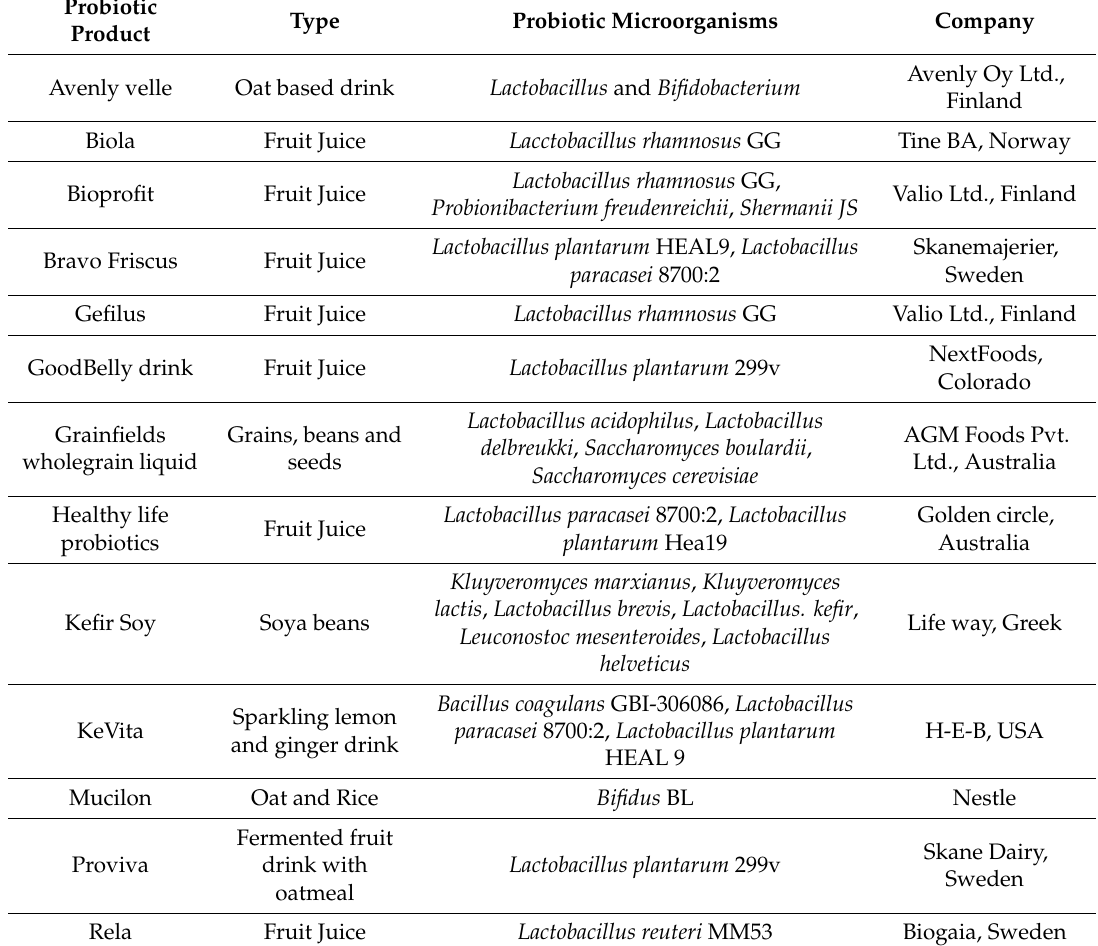
Table 1. Commercially available non-dairy based probiotic